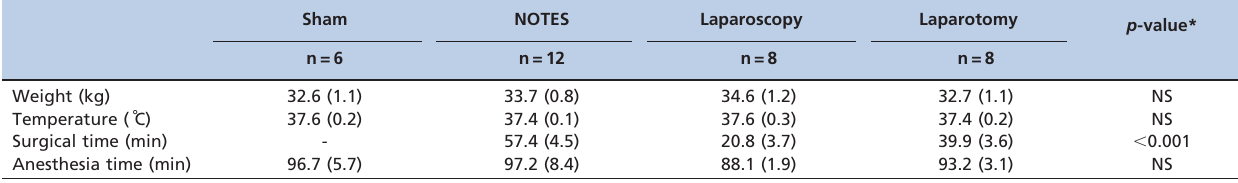
Table 1 - Weight, rectal temperature, surgical time and anesthesia time of the animals used in this study. Sham